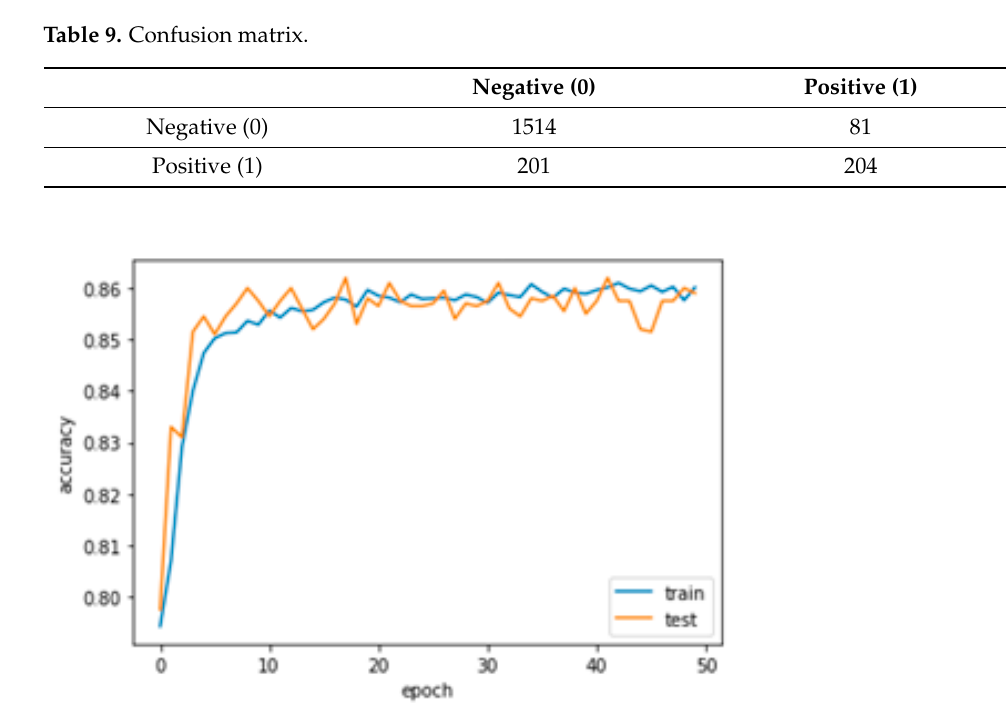
Figure 5. Accuracy of the deep neural network. The model’s loss (error margin), which was the value that the model predicted incor- rectly, was calculated using the same confusion matrix, but it considered only the false values (see Figure 6).